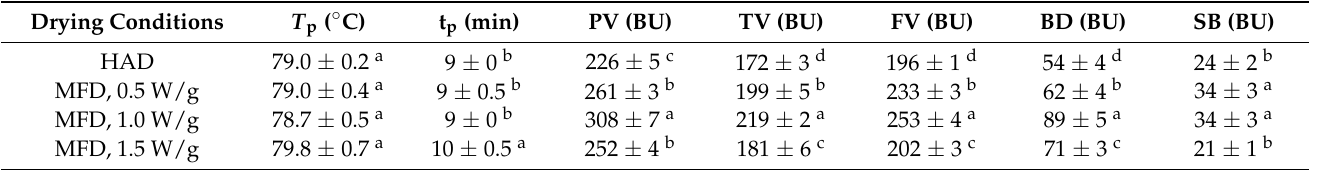
Values are expressed as mean ± SD. Different letters in the same column indicate significant difference at p < 0.05. T p , pasting temperature; t p , peak time; PV, peak viscosity; TV, trough viscosity; FV, final viscosity; BD, breakdown viscosity; SB, setback